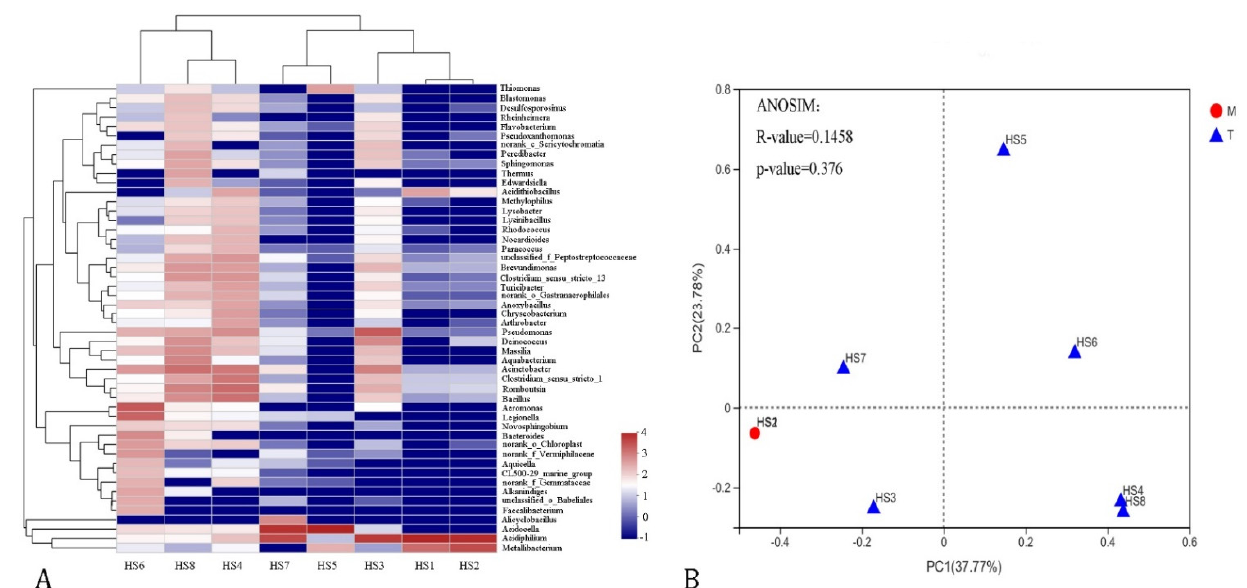
Figure 3. ( A ) A hierarchical clustering heatmap showing the main bacterial species in different groups at the genus level. Each rectangle is colored on the basis of a log 10 value of the taxa percentage, as shown in the legend at the right of the plot. The top tree showed the clustering relationship of the samples. ( B ) A principal coordinates analysis of the main stream (red) and tributary stream (blue) of the Huangshui River based on the composition and abundance of the bacterial communities at the OUT level.